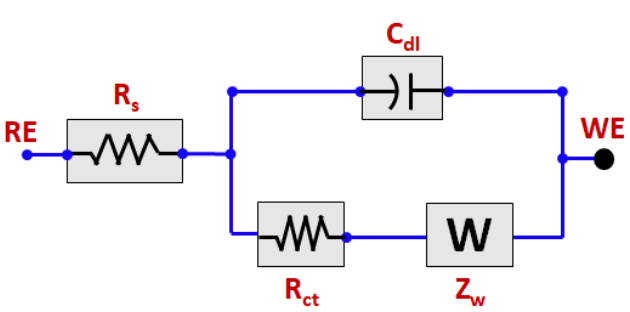
Figure 6. Equivalent circuit model for EIS fitting. Table 1. EIS data of MFC.